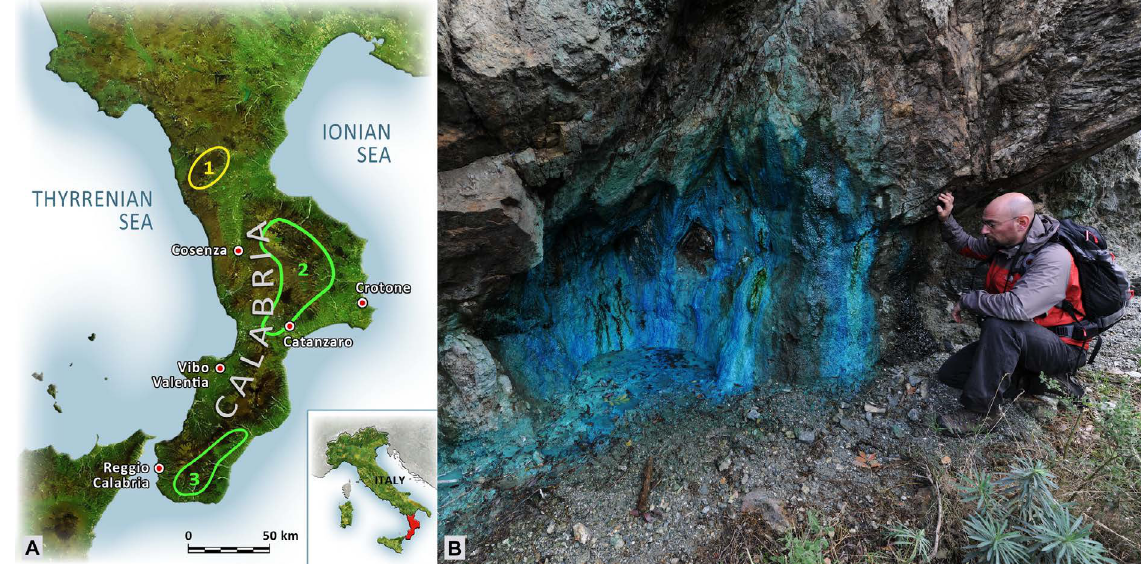
Figure 6 . A. Map of Calabria with indication of the three prehistoric mining districts, one of which is certain (in yellow, 1) and two probable (in green, 2-3); B. Outcrops of copper ore in the third district, the south-eastern one (A. Design by F. Breglia; B. Photo by F.